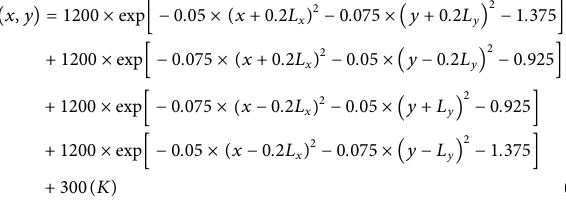
Frontiers in Energy Research |